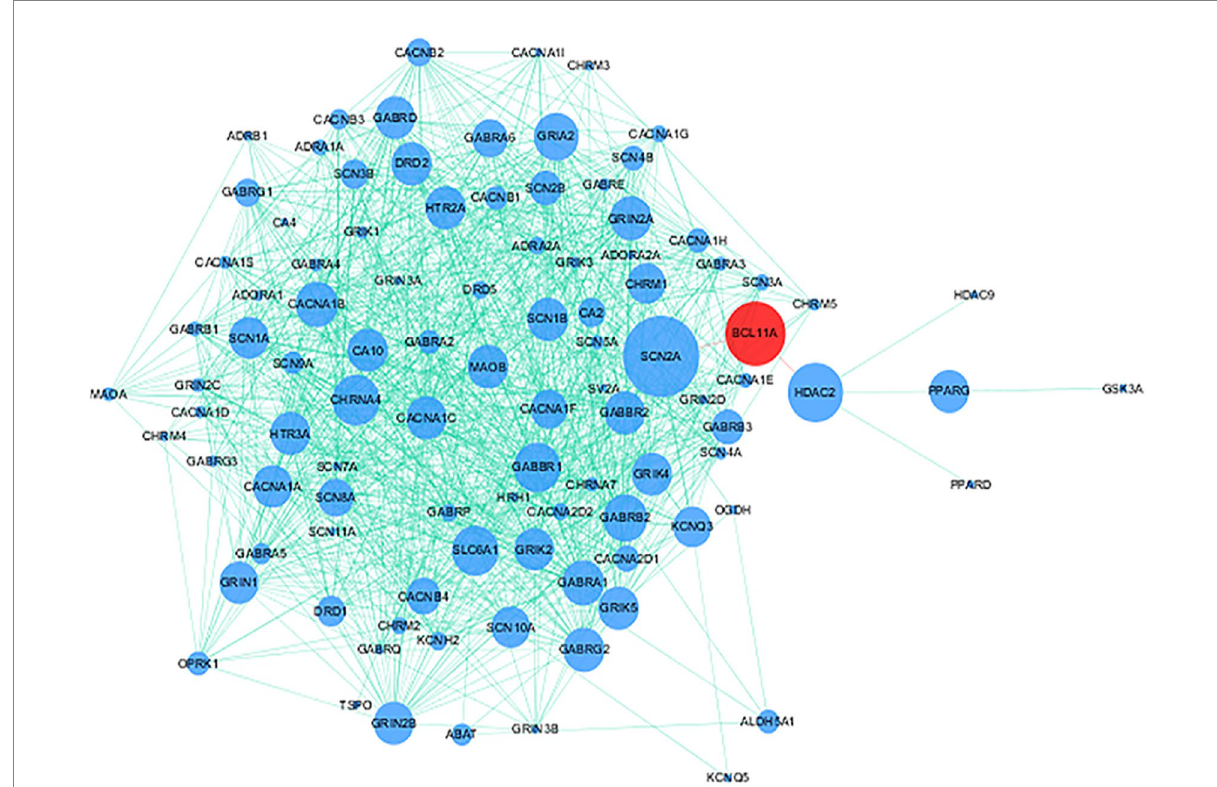
FIGURE 4 Protein–protein interaction (PPI) network of BCL11A gene and genes targeted by approved antiepileptic drugs. Red node and blue nodes represent BCL11A gene and genes targeted by approved antiepileptic drugs, respectively. The proteins connected by the red line mean that these proteins have direct